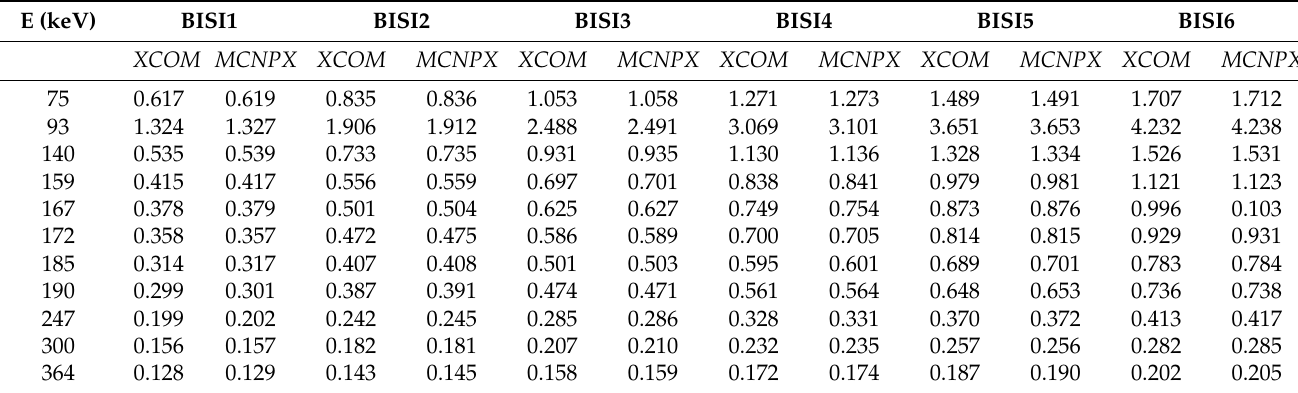
Table 2. Comparison of mass attenuation coefficients obtained from MCNPX [34] and XCOM